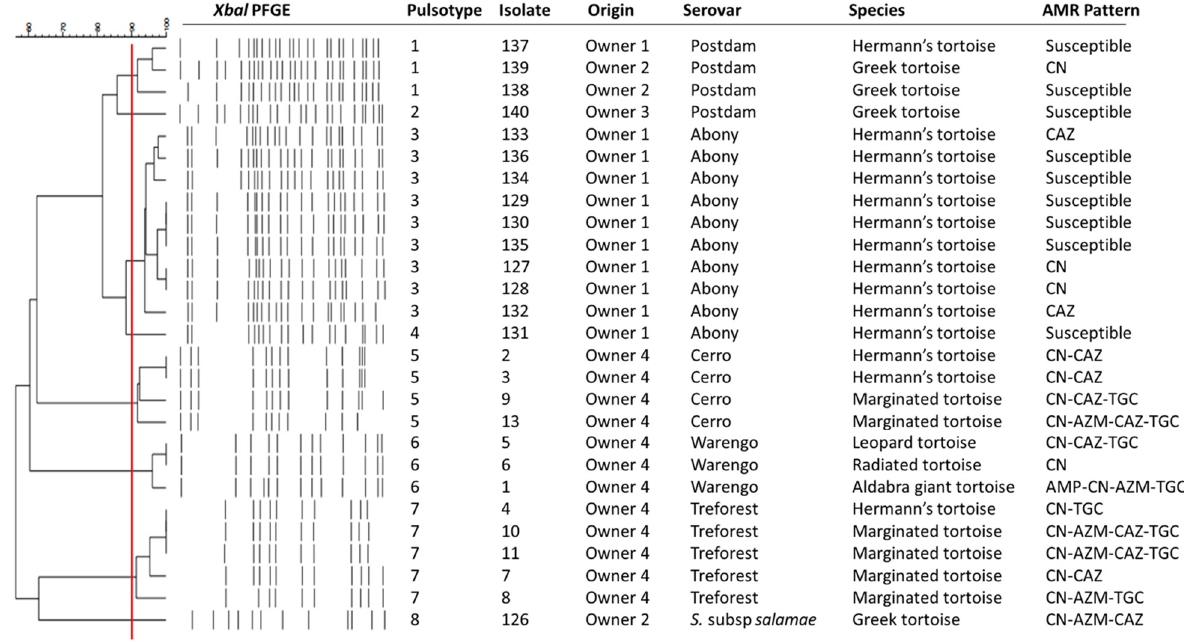
Figure 1. Dendrogram of the XbaI PGFE profiles from a subset of Salmonella strains isolated from chelonials. AMR: Antimicrobial resistance.